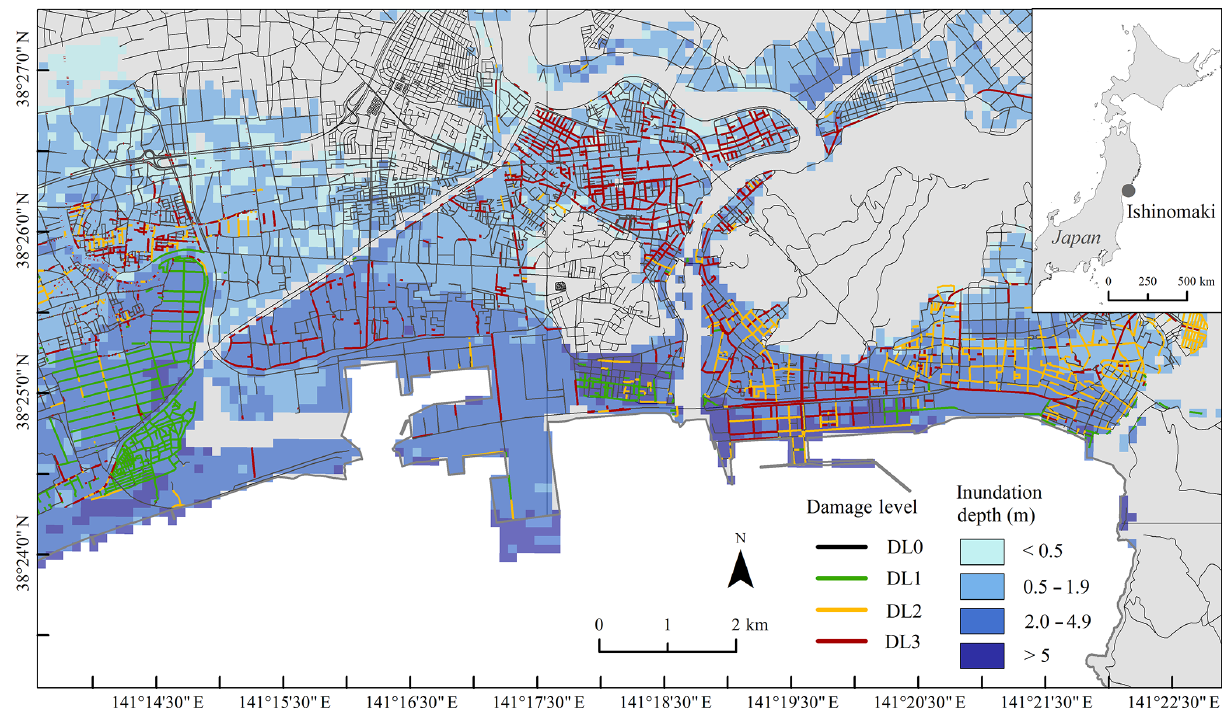
Figure 4. Tsunami inundation and road damage in Ishinomaki from the 2011 T¯ohoku earthquake and tsunami, Japan. Road-impact data modified from MLIT, 2012. © OpenStreetMap contributors 2015. Distributed under a Creative Commons BY-SA License.